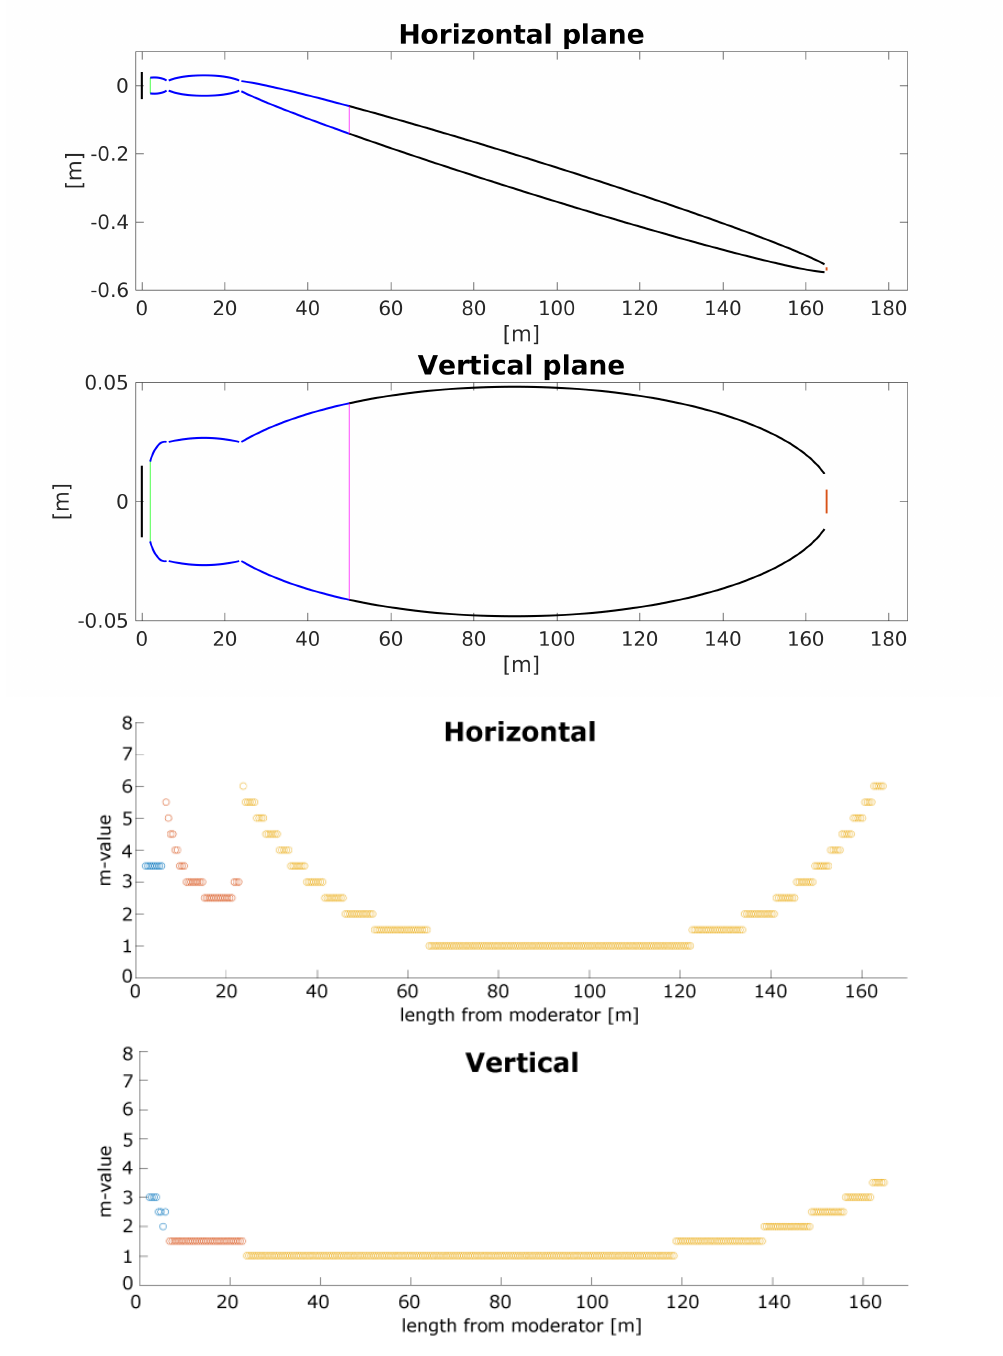
Figure A5. Kinked guide. Guide dimensions and coating values. Top panels: Schematic drawing of the kinked guide, optimized for the wavelength band 1.5–4.0 Å. The figures are not to scale. Bottom panels: The optimized m-distribution in the horizontal and vertical directions,